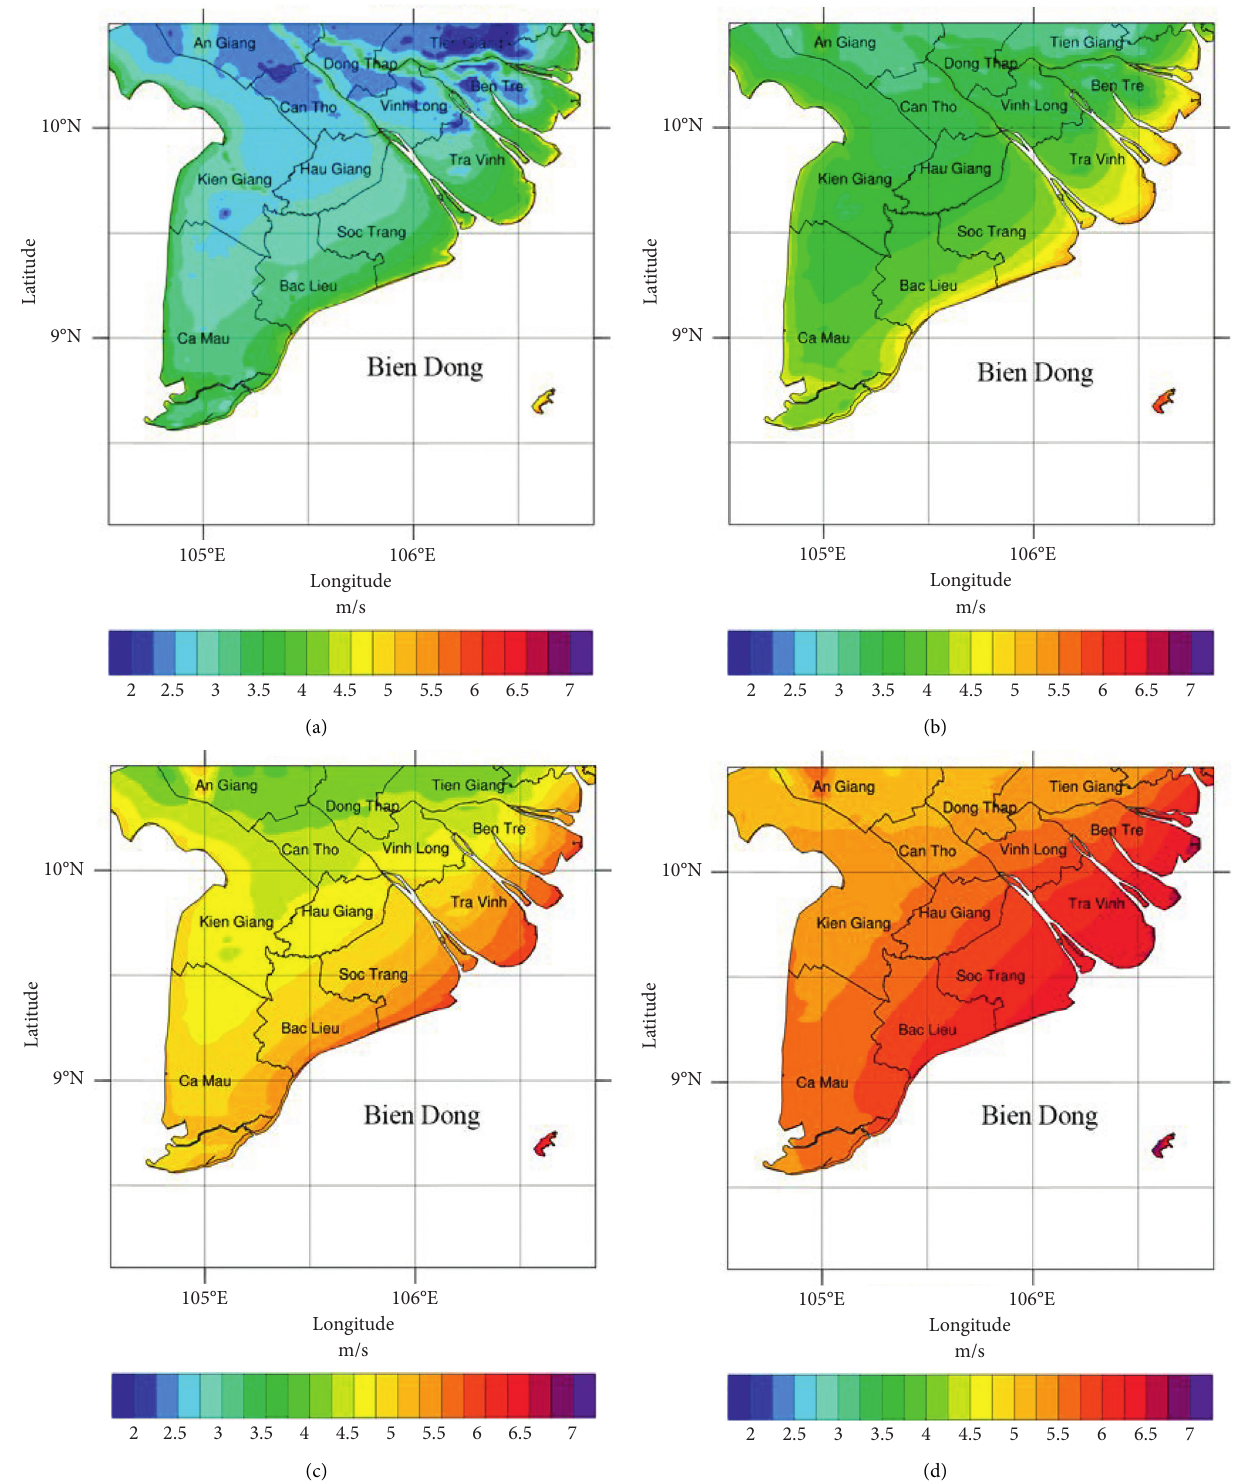
Figure 7: Annual mean of simulated wind speeds (m s − 1 ) from 2 km resolution domain at (a) 20m, (b) 50m, (c) 100m, and (d) 200m